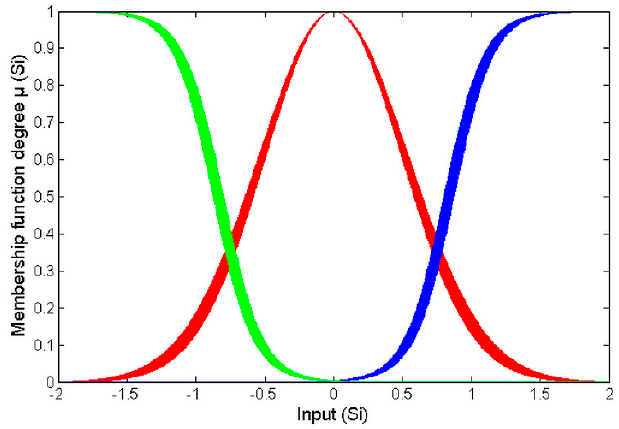
Figure 9. Membership functions of the IT2 adaptive fuzzy reaching sliding mode system (IT2-AFRSMS) ˆ u sm ( i ) .